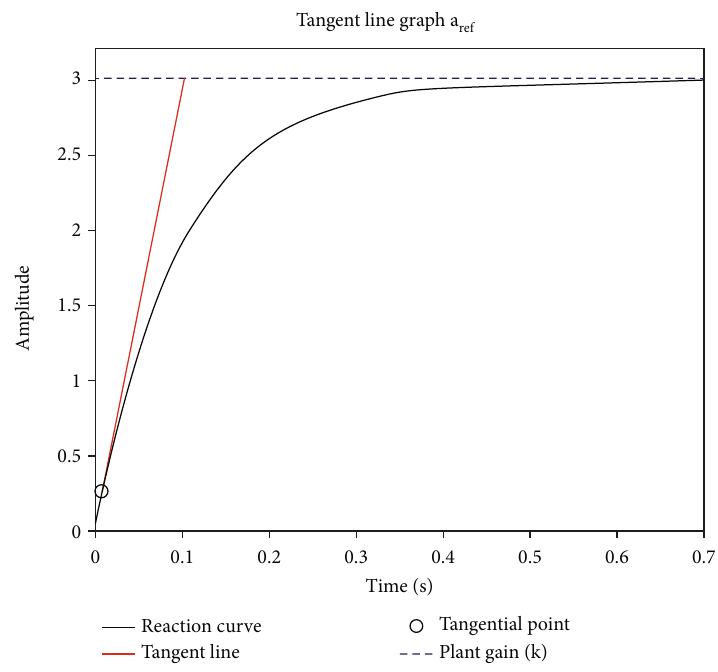
Figure 21: Reaction curve or a